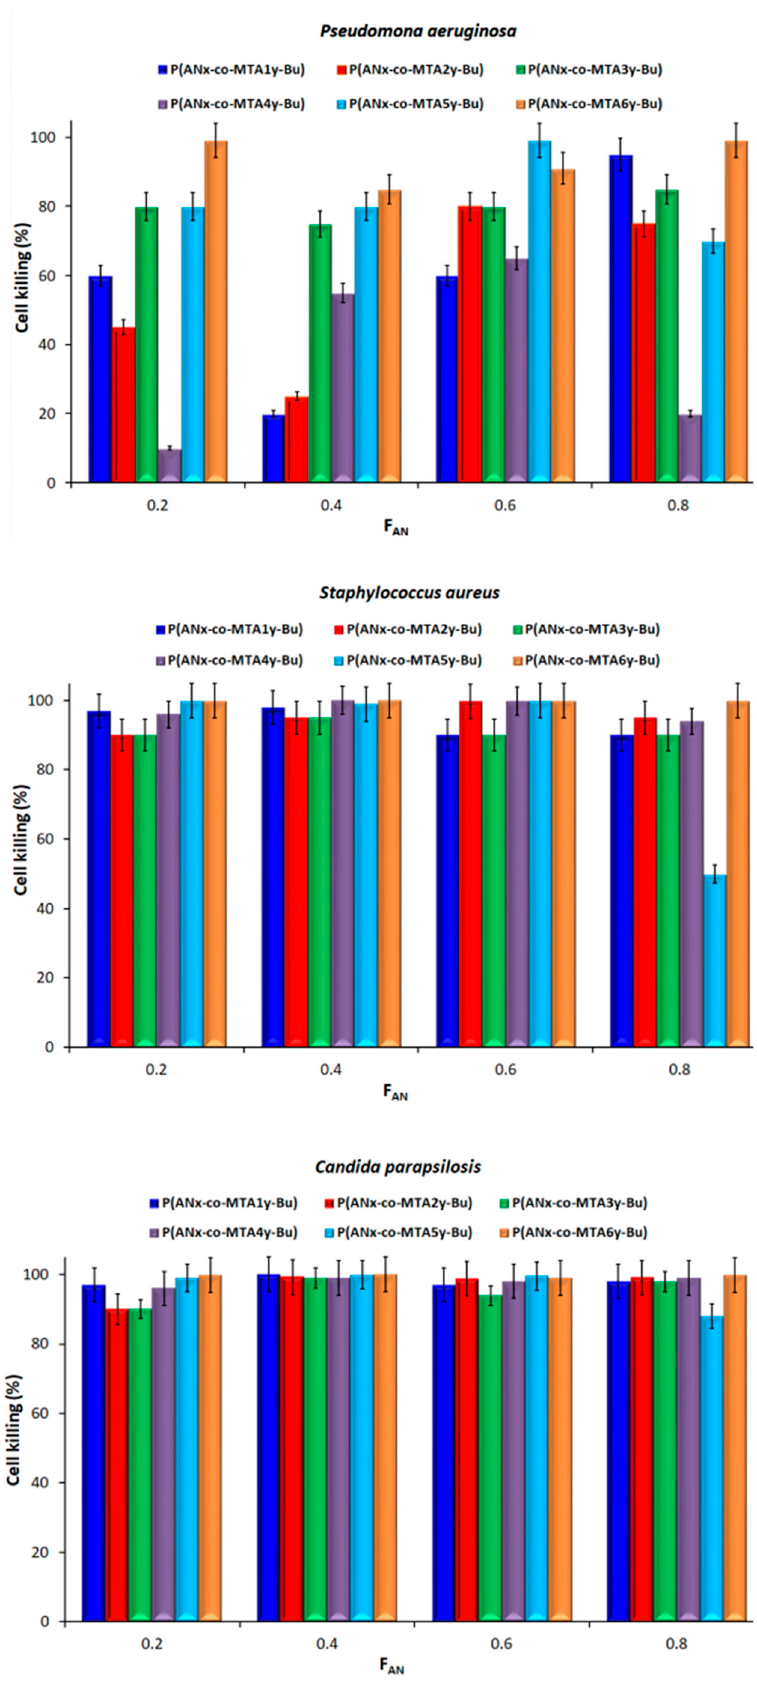
Figure 3. Cell-killing percentage of the contact active films for P. aeruginosa , S. aureus and C. parapsilosis microorganisms.